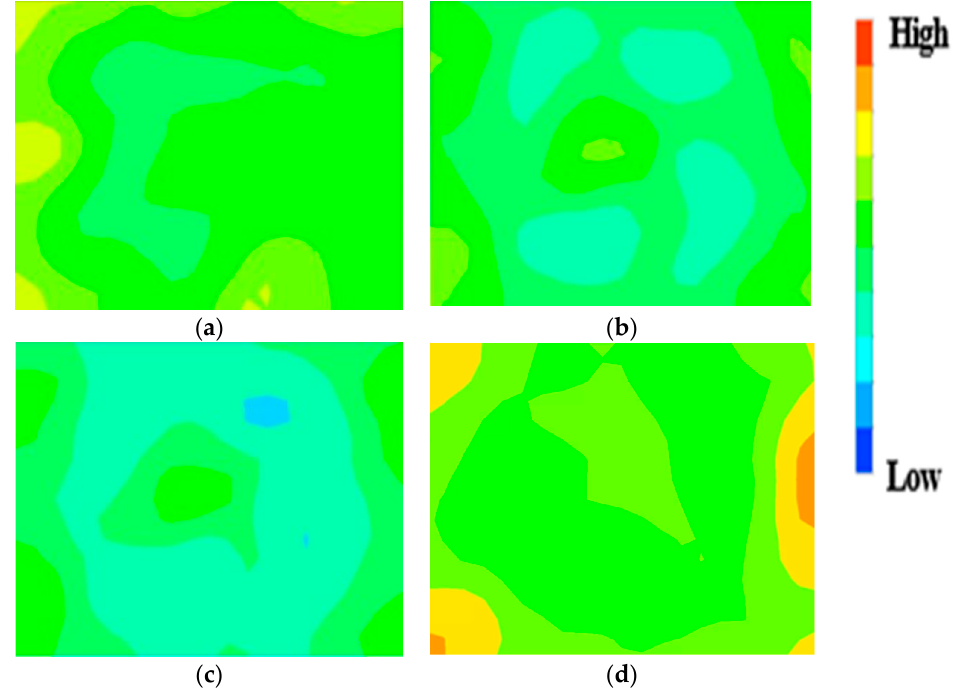
Figure 13. NH 3 distribution with filter porosity: ( a ) 30%, ( b ) 50%, ( c ) 70%, ( d ) 90%.